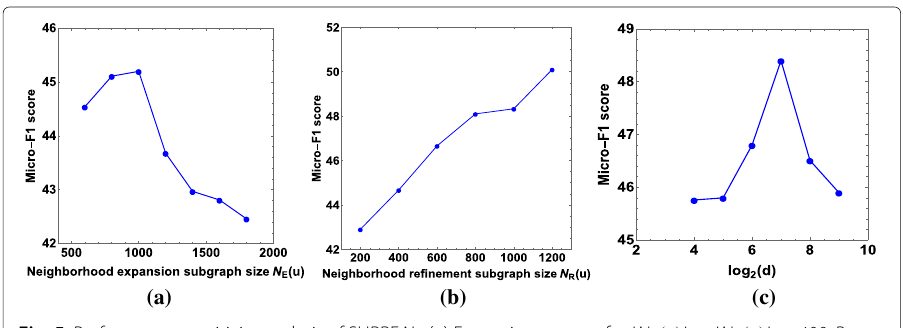
Fig. 5 Performance sensitivity analysis of SURREAL. ( a ) Expansion process for | N E ( u ) | ≥ | N R ( u ) | = 400. By